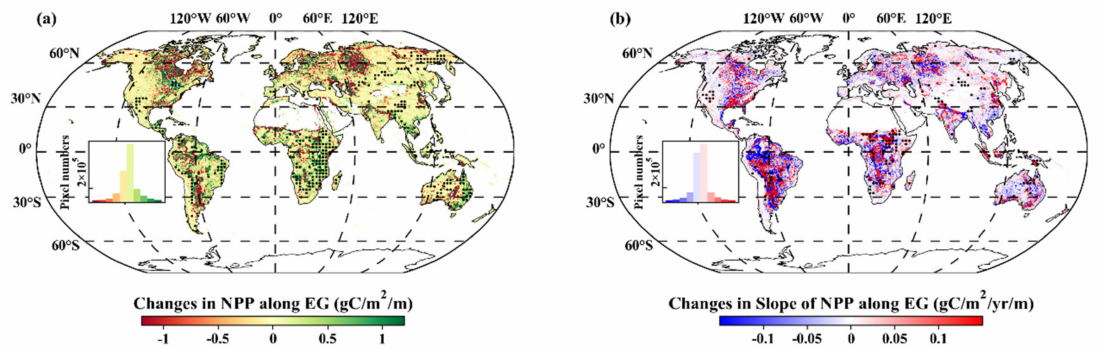
Figure 6. Spatial pattern of the changes in NPP ( a ) and its slope ( b ) along EG from 2001 to 2020. The value frequency is in the left of each subfigure. The regions with black dots indicate that the trend is statistically significant at the 0.05